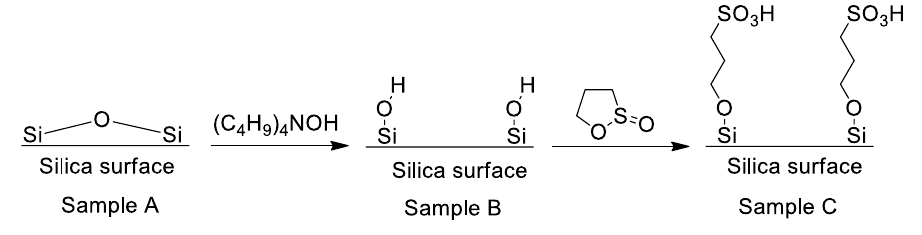
Figure 4. Surface modification of SCC.